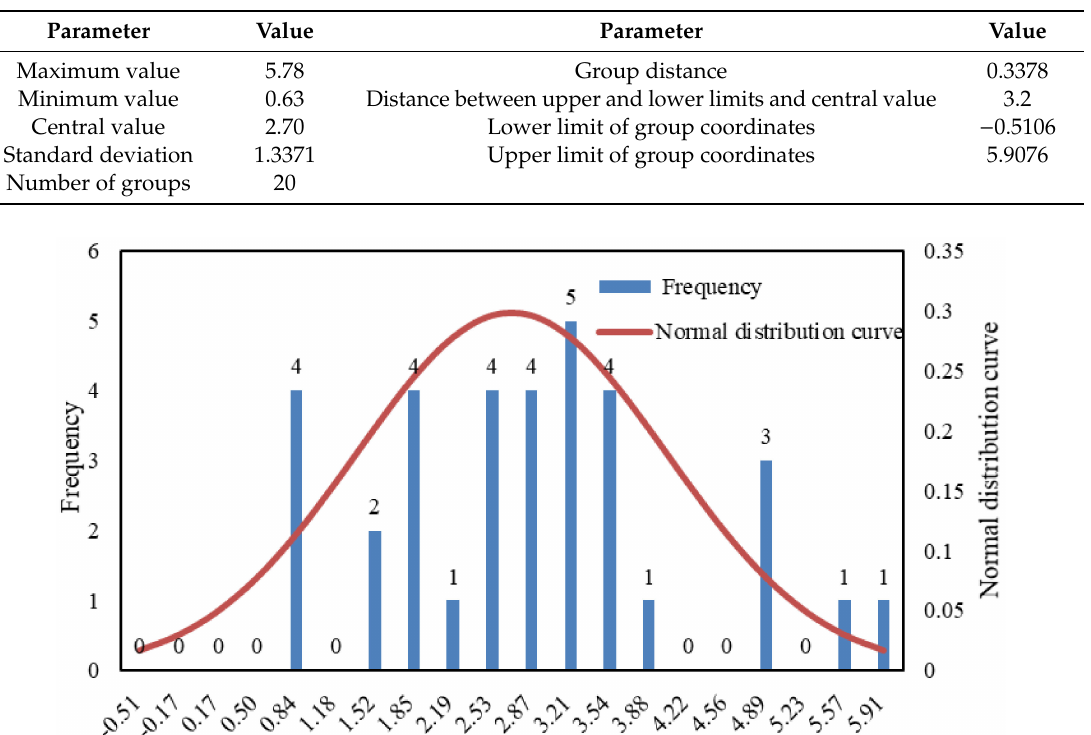
Table 9. Calculation of normal distribution.